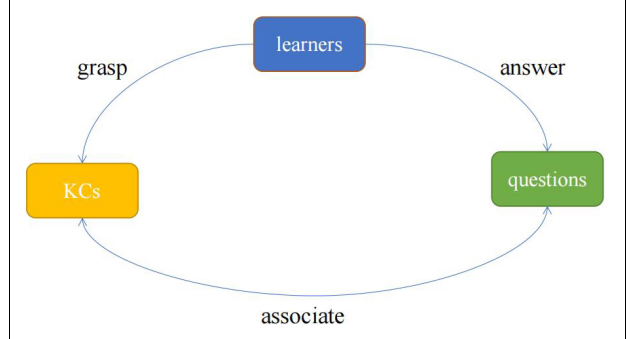
FIGURE 1 | The relationship between learners, questions, and